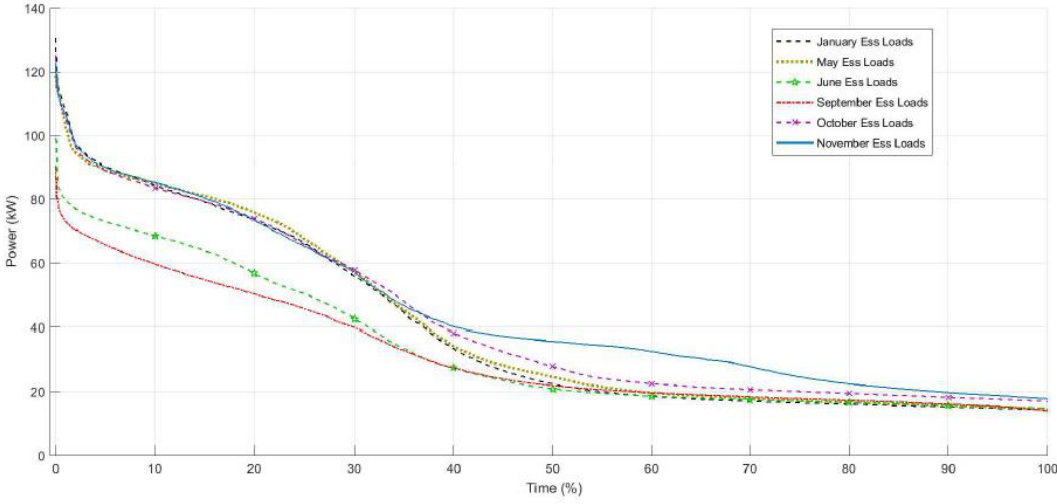
Figure 5. Monthly load duration curves.